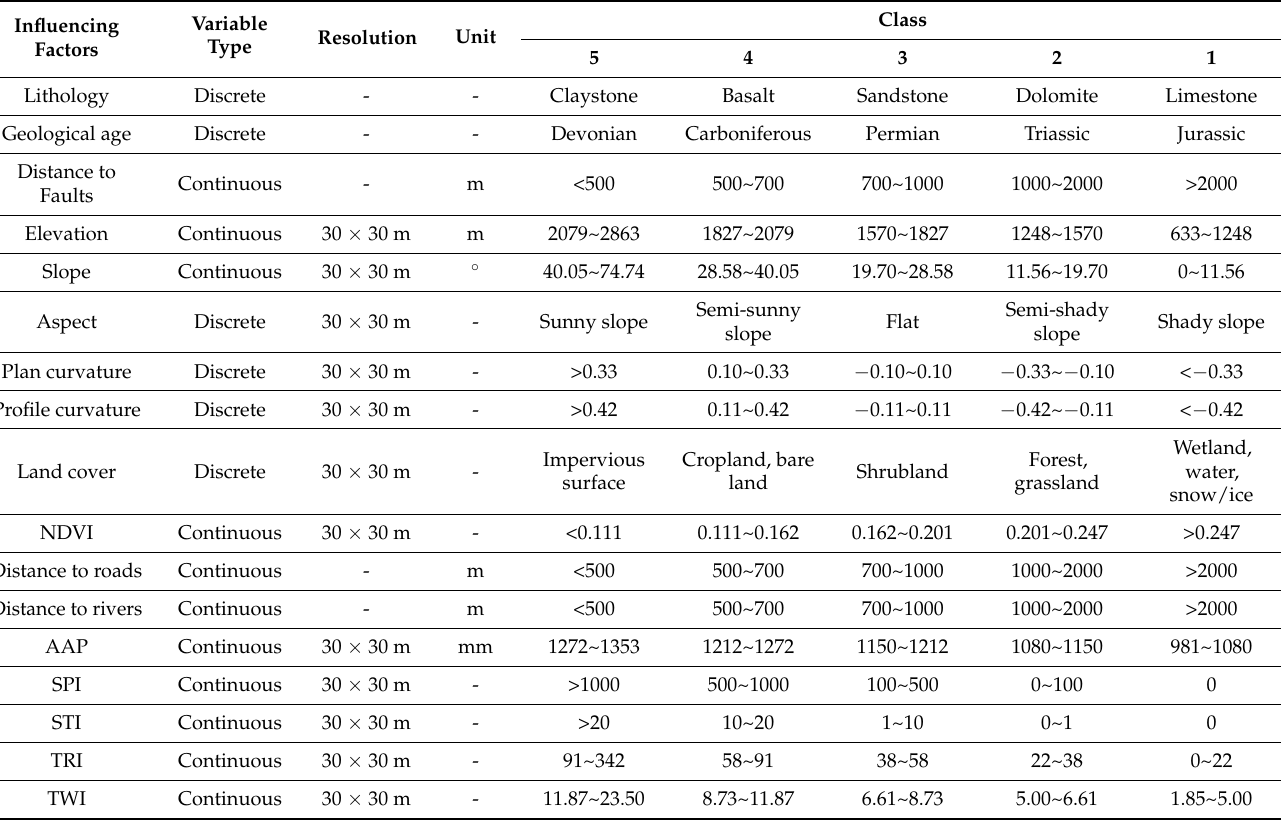
Table 1. The classification of each influencing factor